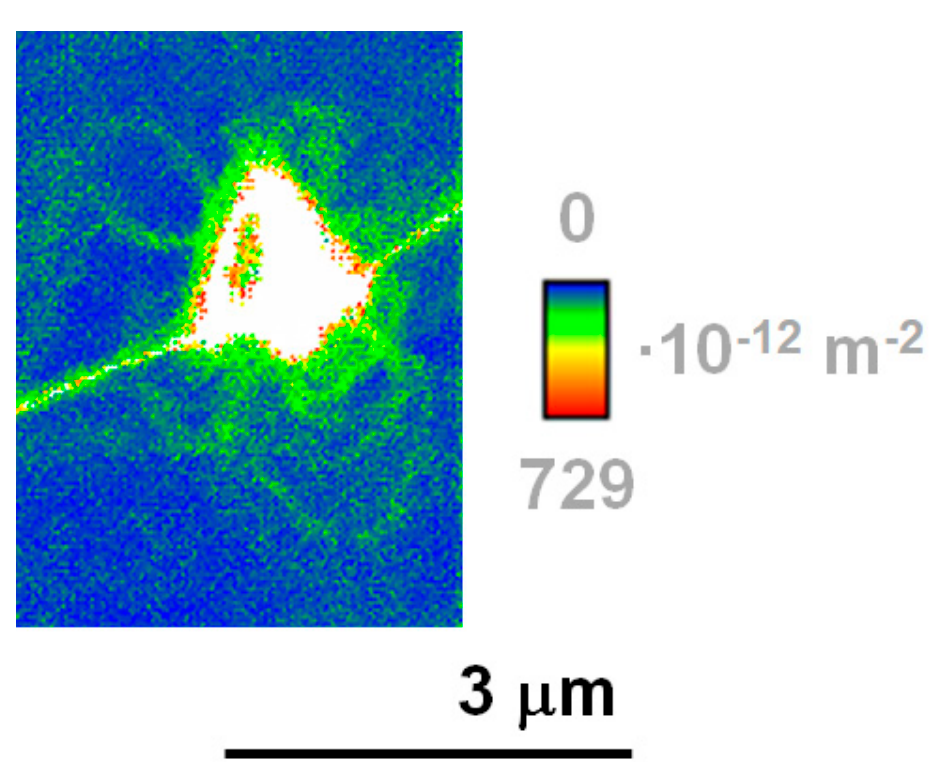
Figure 4. GND map of a residual imprint performed at 200 nm of maximum displacement into surface showing the dislocation map induced during the indentation process.